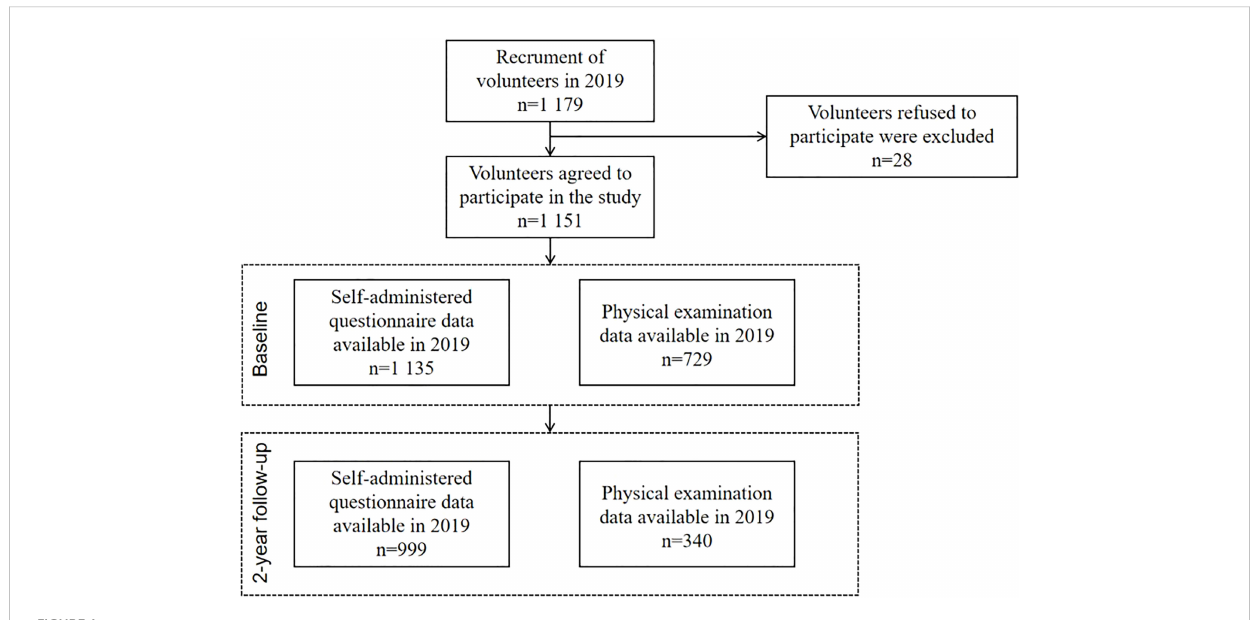
FIGURE 1 Flowchart of sample populations in our